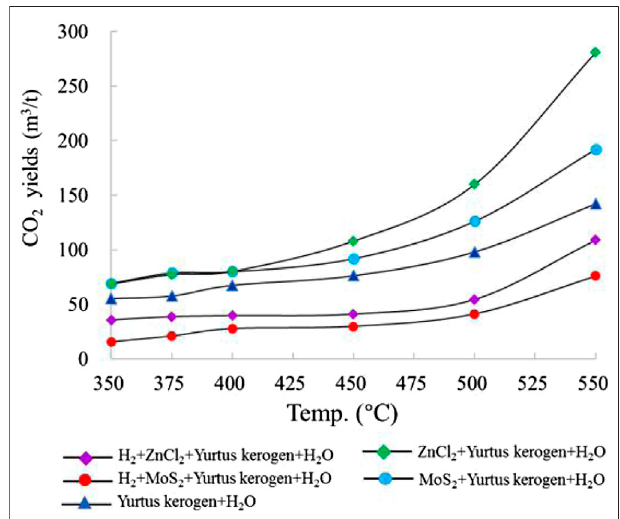
FIGURE 3 | Change in C 3 yield simulated under different catalytic hydrogenation control conditions of the closed system.